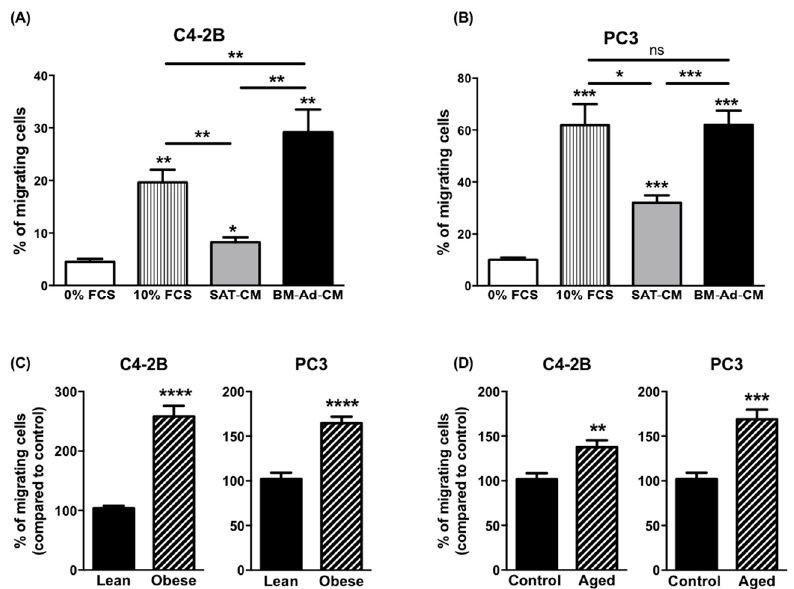
Figure 1. The chemotaxis of PCa cells towards BM-Ad-CM is enhanced by obesity and ageing. In vitro migration of C4-2B ( A ) or PC3 ( B ) towards a medium containing either 0% (used as a negative control), 10% FCS or towards SAT-CM or BM-Ad-CM ( n = 4–5/group). Statistical analysis by One-way ANOVA with Holm-Sidak’s multiple comparisons test was performed. ( C ) In vitro migration of the indicated PCa cell lines towards BM-Ad-CM from lean (age: 62.8 ± 6.9 years, BMI: 21.4 ± 3.3 kg/m 2 ) or obese (age: 63.3 ± 10.1 years, BMI: 33.3 ± 2.3 kg/m 2 ) subjects ( n = 5/group). ( D ) Similar experiments were performed with aged (age: 75.7 ± 5.7 years, BMI: 23.3 ± 4.3 kg/m 2 ) and younger control (age: 60.2 ± 5.2 years, BMI: 22.1 ± 3.5 kg/m 2 ) subjects ( n = 5/group). Data are shown as mean ± sem ( A , B ) or mean of migrating cells (with the control groups set at 100%) ± sem ( C , D ). Statistical analysis by Student’s t-test was performed. * p < 0.05, ** p < 0.01, *** p < 0.001, **** p < 0.0001, ns: not